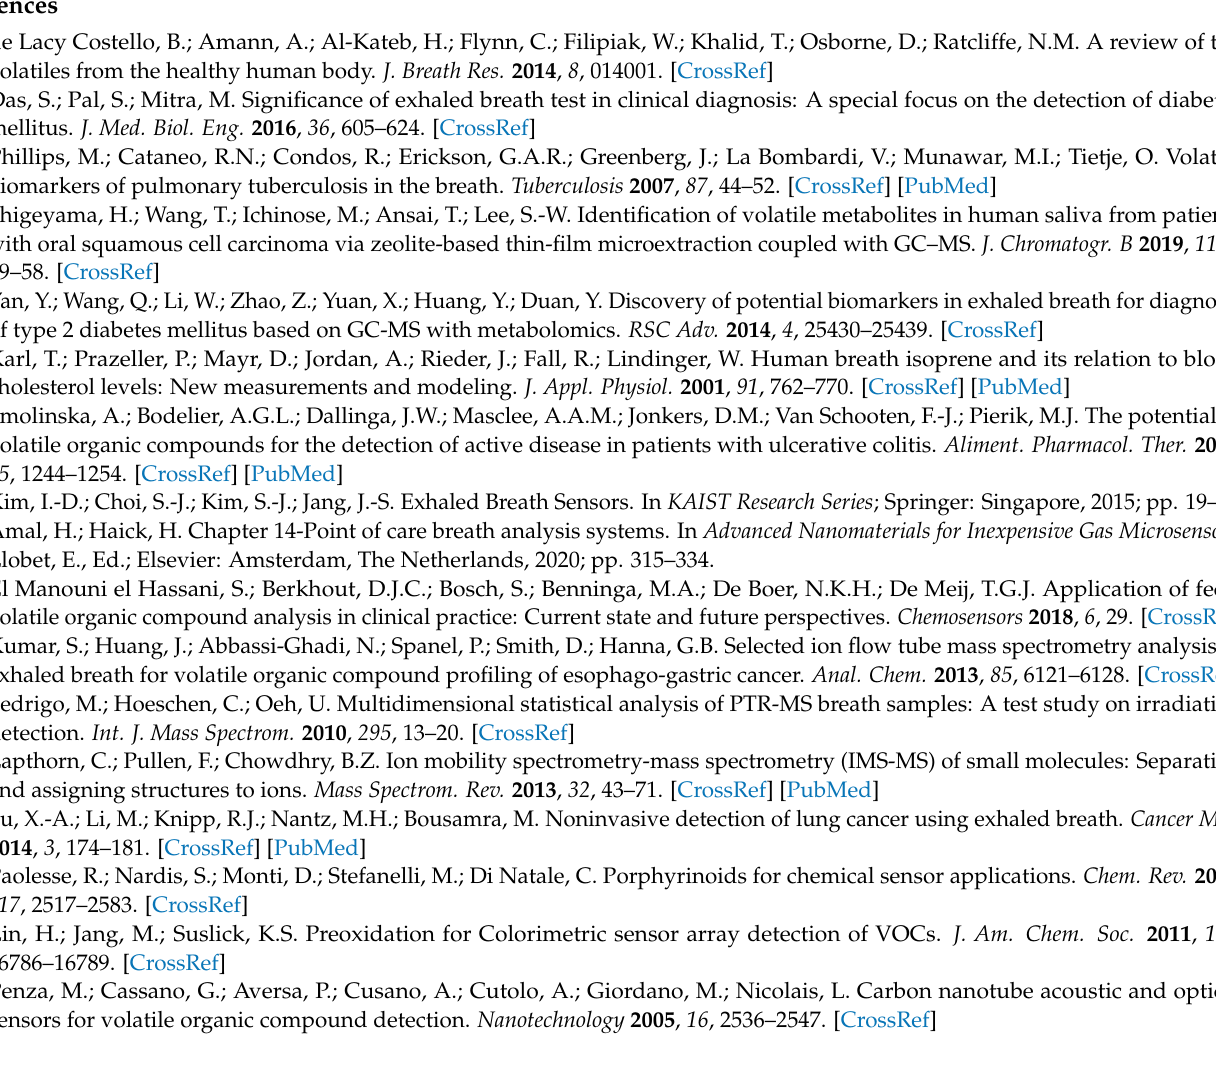
Figure S2: F1-score results of bootstrapped samples for ( a ) acetone, ( b ) isopropanol, ( c ) ammonia, and ( d ) carbon monoxide classification; Table S2: R norm (%) of four different RGO–metalloporphyrin films at different ammonia